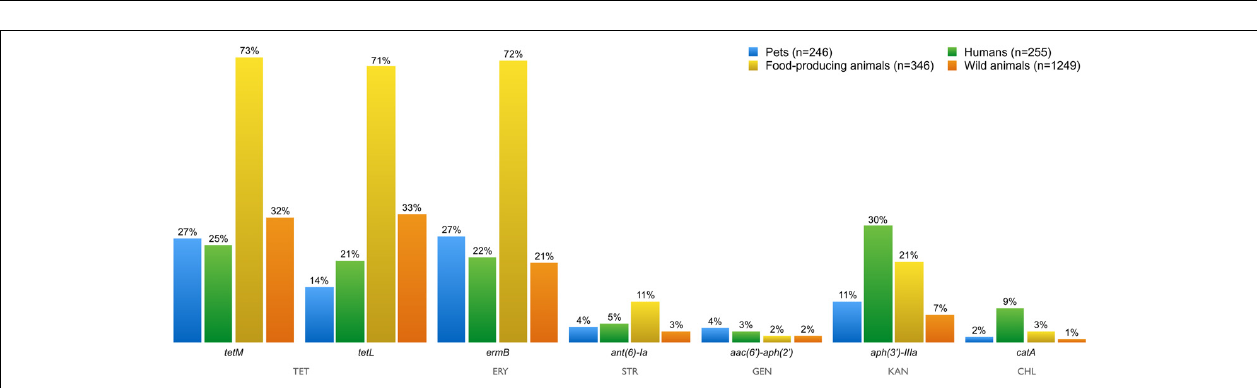
FIGURE 7 | Percentage of AMR genes detected in resistant Enterococci isolates from all sources over a decade. Resistance genes tet(M)/tet(L), erm(B), ant(6)-Ia, aac(6 (cid:48) )-aph(2 (cid:48) ), aph(3 (cid:48) )-IIIA, and catA were present in enterococci isolates resistant to tetracycline, erythromycin, streptomycin, gentamicin, kanamycin, and chloramphenicol, respectively. TET, tetracycline; ERY, erythromycin; STR, streptomycin; GEN, gentamicin; KAN, kanamycin, CHL, chloramphenicol.